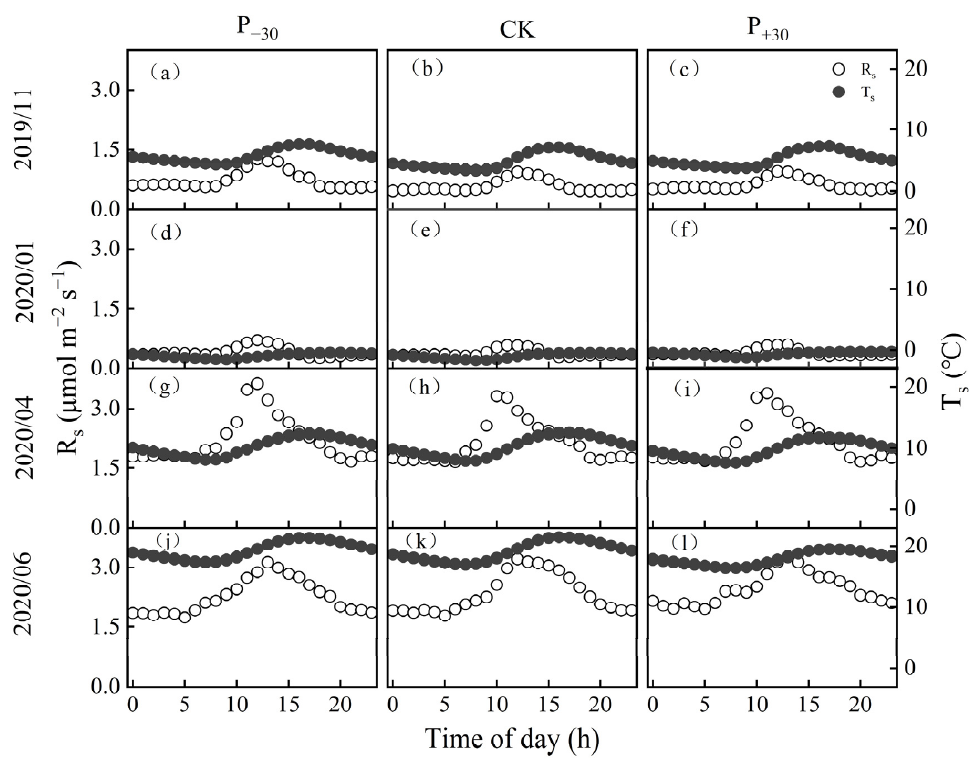
Figure 4. Mean monthly diel cycles of soil respiration (R s , open points) and soil temperature (T s , solid points) at a depth of 10 cm in November 2019 ( a – c ) and January ( d – f ), April ( g – i ), and June ( j – l ) 2020.